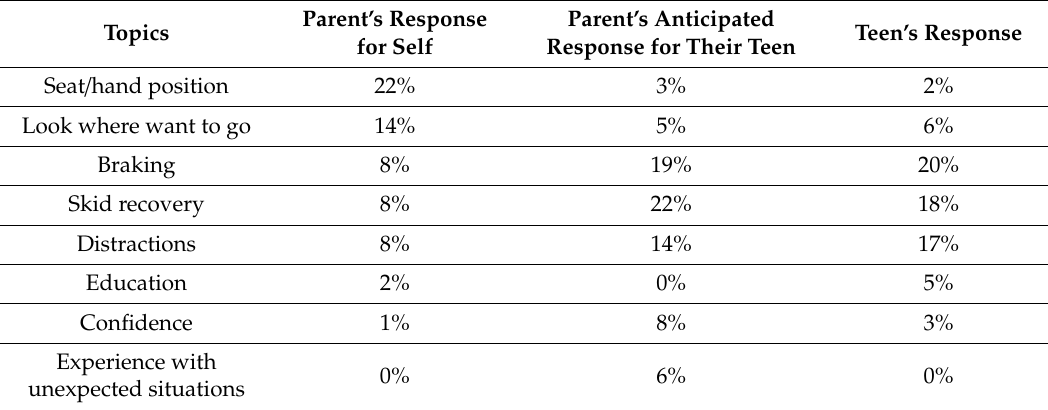
Table 2. Top three things learned for the parent’s response, parent’s anticipated response for their teen, and the teen’s response.